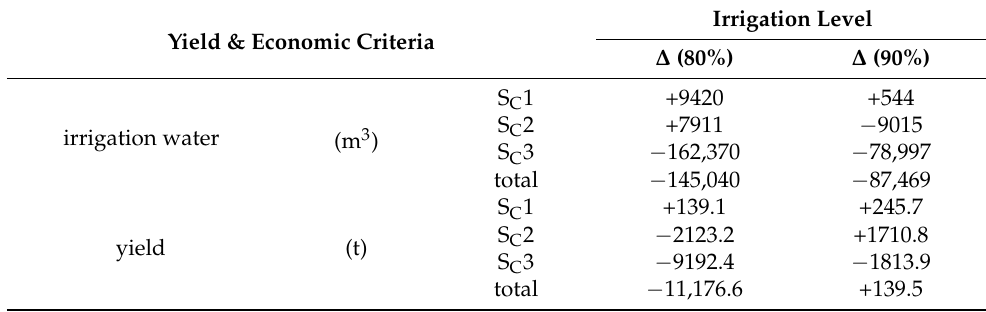
Table 6. Possible water savings (m 3 ), changes in yield (t) and starch yield (t), and economic indices and responses (total production value and total production value with regard to tuber quality losses, USD) of farm level 80% and 90% irrigation levels using the local farm in Mecklenburg–Western Pomerania, Germany (1600 ha), on which 695.3 ha were of loamy sand and used for starch potato cultivation in 2021. Differences ∆ were calculated in comparison to the common irrigation of the local farmer (100%, 828,797.60 m 3 at the farm level in 2021). Irrigation Level Yield & Economic Criteria ∆ (80%) ∆ (90%) S C 1 +9420 +544 S C 2 +7911 − 9015 irrigation water (m 3 ) S C 3 − 162,370 − 78,997 total − 145,040 − 87,469 S C 1 +139.1 +245.7 S C 2 − 2123.2 +1710.8 yield (t) S C 3 − 9192.4 − 1813.9 total − 11,176.6